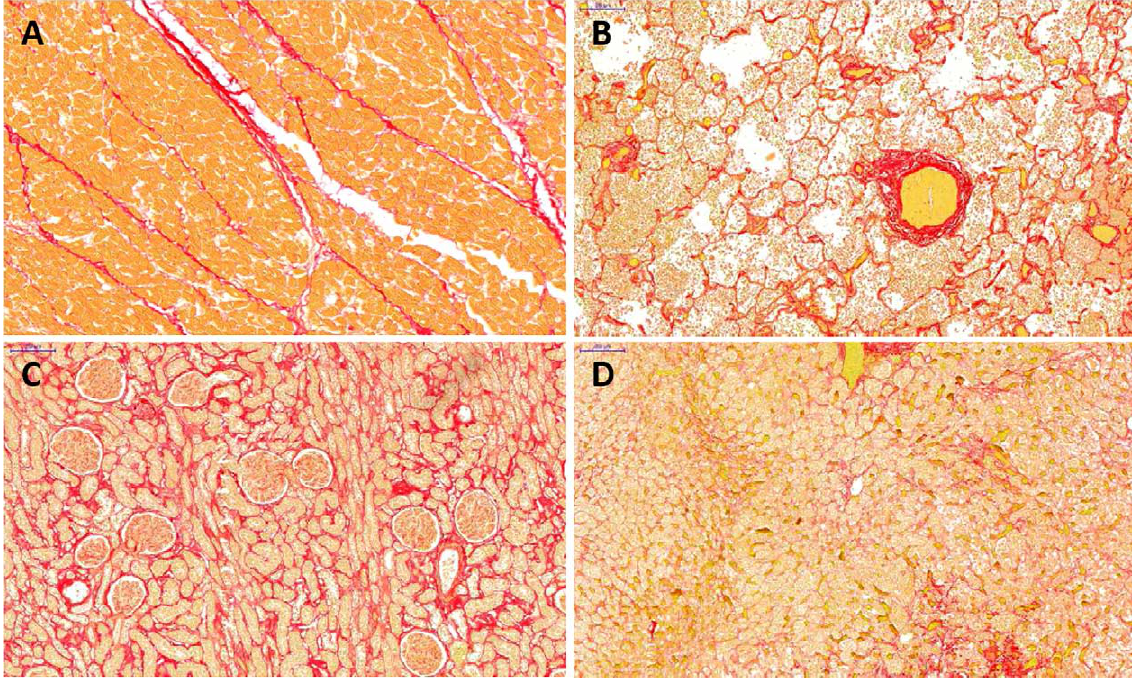
Fig. 6. Picrosirius red staining was also performed on human (A) myocardial tissue, (B) lung, (C) kidney and (D) liver and scanned with Mirax scan. (Colors are visible in the online version of the article;